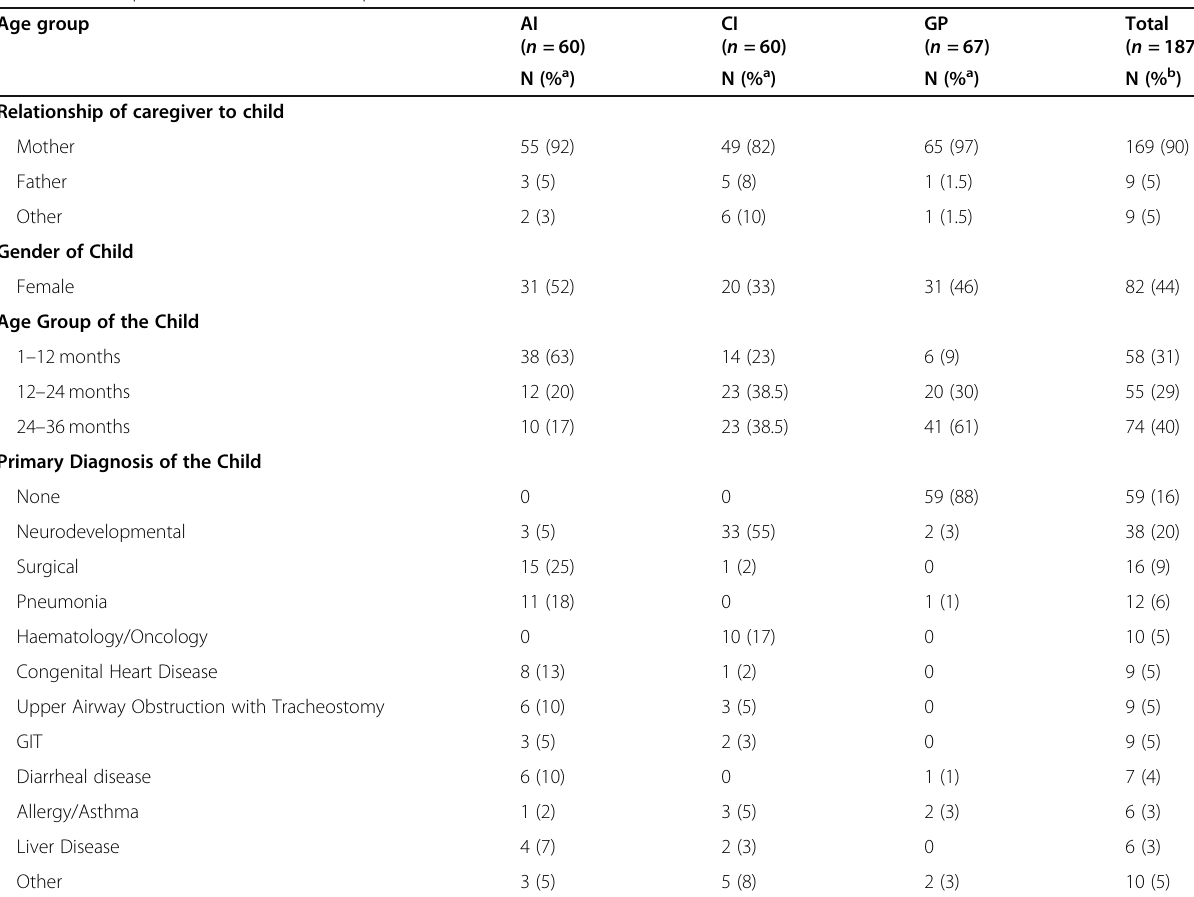
Table 2 Descriptive statistics of the sample Age